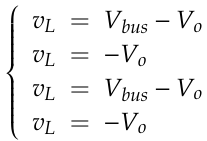
Figure 4. Power flow and related waveforms in boost mode. ( a ) Power flow in Mode I. ( b ) Power flow in Mode II. ( c ) Power flow in Mode III. ( d ) Power flow in Mode IV. ( e ) Related waveforms during boost mode. t ~ t ): During the t to t period, Mode I ( 1 1 2 2 are turned off. The battery charges the inductance and energy can be stored in the inductance resulting in the inductance current rising slowly in the negative direction. The current flows from